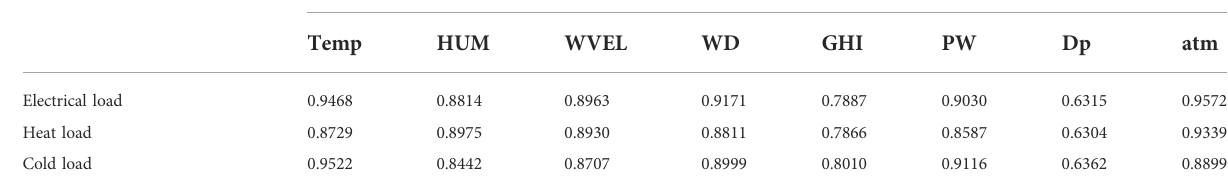
TABLE 2 Correlation analysis between multivariate load and NWP characteristics.